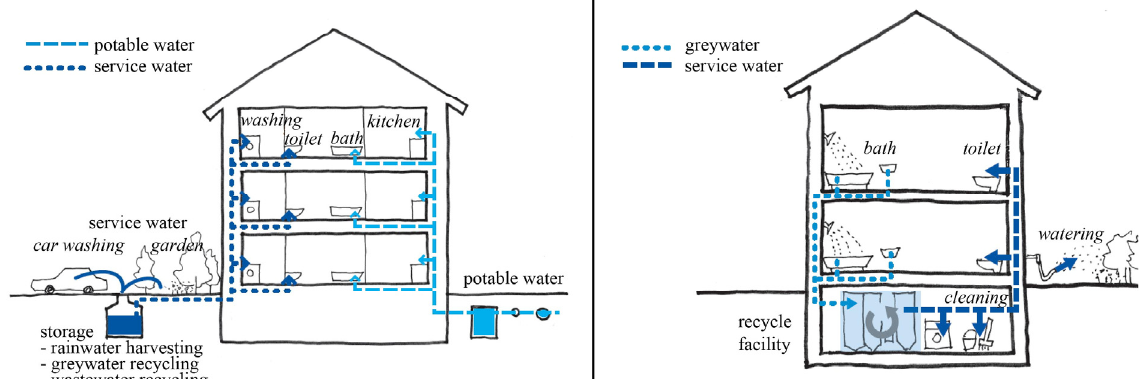
Figure 4. Section of a building with centralized potable water supply and secondary water supply, with service water ( left ). Recycling of greywater from bathrooms on building level ( right